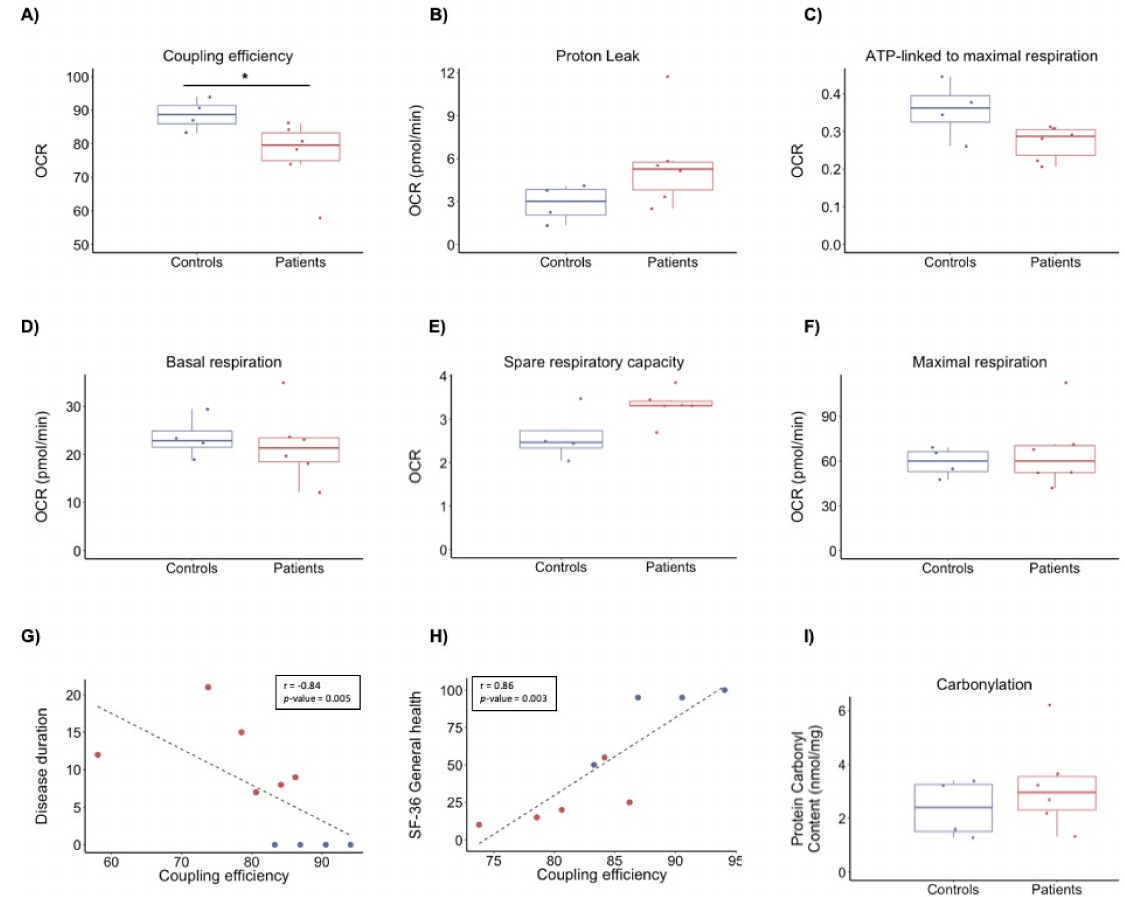
Figure 2. Bioenergetics profile of PBMCs from ME/CFS patients and healthy individuals as controls. Rates of mitochondrial respiration were measured in PBMCs using the Seahorse XFe96 instrument with added glucose, pyruvate, and glutamine. ( A ) Coupling efficiency (%) calculated as the ratio of ATP-linked respiration to basal respiration. ( B ) Proton leak calculated after the addition of oligomycin. ( C ) ATP-linked to maximal respiration calculated as the ratio of ATP-linked respiration to maximal respiration. ( D ) Basal mitochondrial respiration rates calculated before the addition of inhibitors. ( E ) Spare respiratory capacity calculated as the ratio of maximal respiration to basal. ( F ) Maximal respiration calculated after uncoupling of the respiratory chain by the addition of FCCP. ( G ) Pearson’s correlation between disease duration (y-axis) and coupling efficiency (x-axis) for all 10 individuals. ( H ) Pearson’s correlation between SF-36 general health (y-axis) and coupling efficiency (x-axis) for 9 individuals. The data of one patient lacks due to incompletion of the questionnaires. ( I ) Box plots representing the cellular levels of oxidative protein damage. Blue bar, controls; red bar, ME/CFS patients. n = 10 (4 controls, 6 ME/CFS patients). p -values denote significance from Student’s t-test. * p <